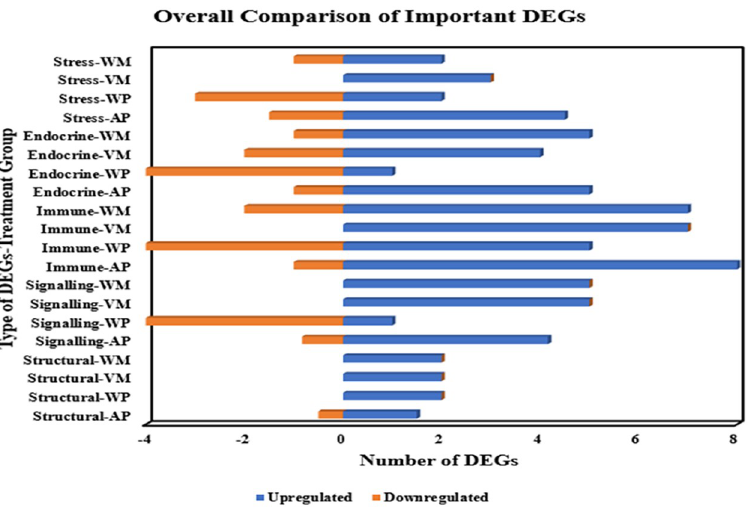
Fig 3. Overall comparison of important DEGs involving type of DEGs-treatment group and number of DEGs. Treatment Groups: WM: WSSV-infected M . rosenbergii ; VM: V . parahaemolyticus -infected M . rosenbergii ; WP: WSSV-infected P . monodon at 12 dpi; AP: Vp AHPND -infected P . monodon . Stress DEGs: Inositol 1,4,5-trisphosphate receptor, Dopamine N-acetyltransferase, Hsp90, Apoptosis-stimulating of p53 protein 1, Caspase, Apoptosis-inducing factor (AIF). Endocrine DEGs: Mitochondrial coenzyme A transporter, ATP binding cassette transmembrane transporter, Trehalose transporter, Polysaccharide lyase, Trypsin, Peroxisomal acyl-coenzyme A oxidase. Immune DEGs: Transglutaminase, C-type Lectin, HMGB, ALF1, ALF3, proPO, Superoxide Dismutase, Glutathione Peroxidase, Catalase. Signalling DEGs: Ceramide synthase, Calcium-activated chloride channel regulator, Inward rectifier potassium channel, STAT, IMD, TBK1. Structural DEGs: Actin,